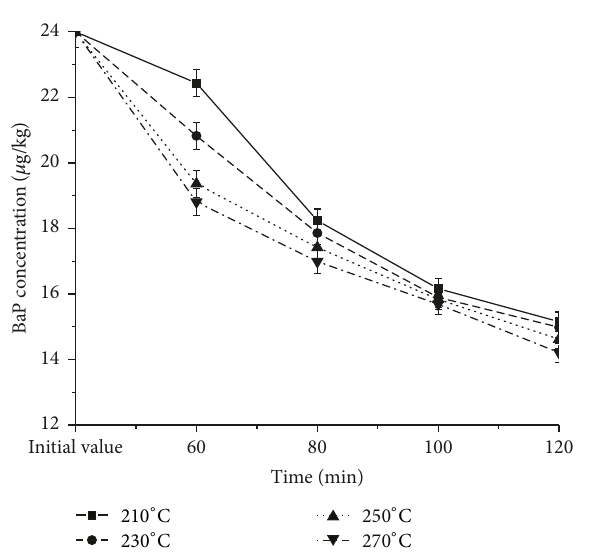
Figure 3: Effect of deodorization on BaP.